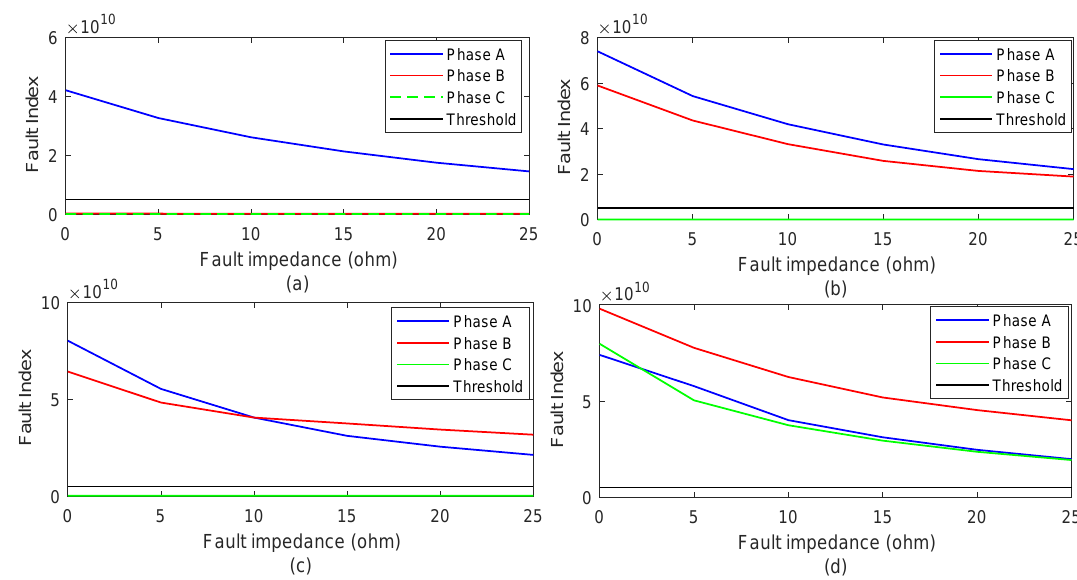
Figure 9. Effect of the varying impedance involved during the fault for detecting and classifying ( a ) L-G, ( b ) LL, ( c ) LL-G, and ( d ) LLL-G